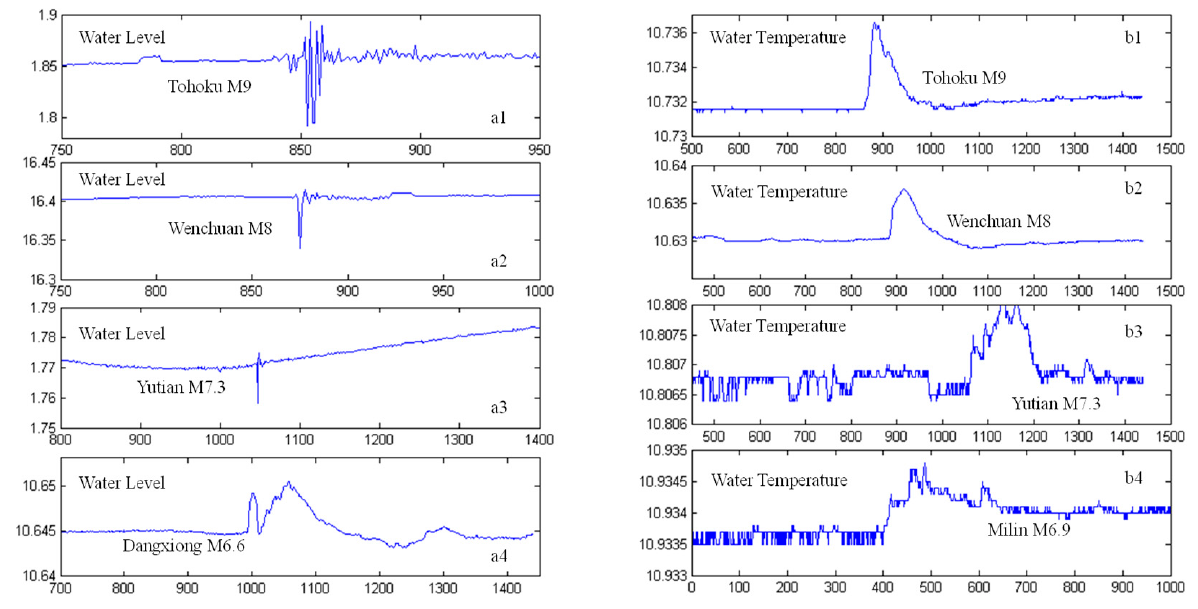
Figure 6. Co-seismic response curves of the digital water level (unit: m) and water temperature (°C) series at the Lhasa geomagnetic station: ( a1 ) water level response to the 2011 M9 Tohoku earthquake; ( a2 ) water level response to the 2008 M8 Wenchuan earthquake; ( a3 ) water level response to the 2014 Yutian M7.3 earthquake; ( a4 ) water level response to the 2008 Dangxiong M6.6 earthquake; ( b1 ) water temperature response to the 2011 M9 Tohoku earthquake; ( b2 ) water temperature response to the 2008 M8 Wenchuan earthquake; ( b3 ) water temperature response to the 2014 Yutian M7.3 earthquake; ( b4 ) water temperature response to the 2017 Milin M6.9